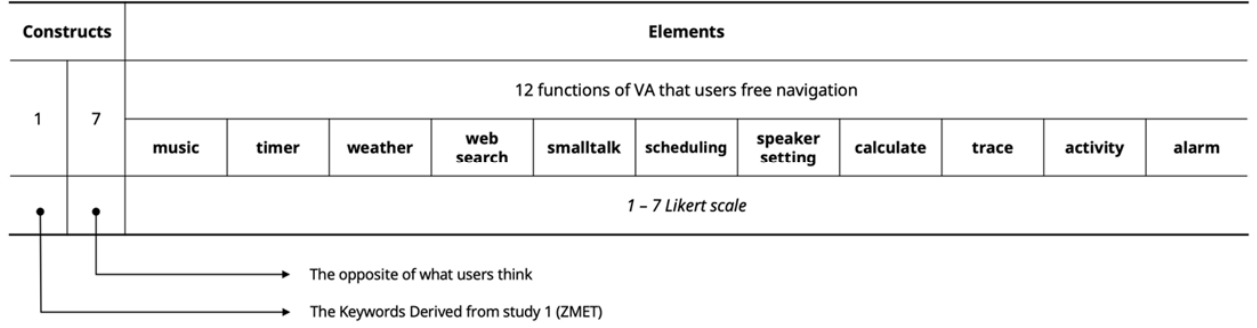
Figure 3. Study 2 Procedure.